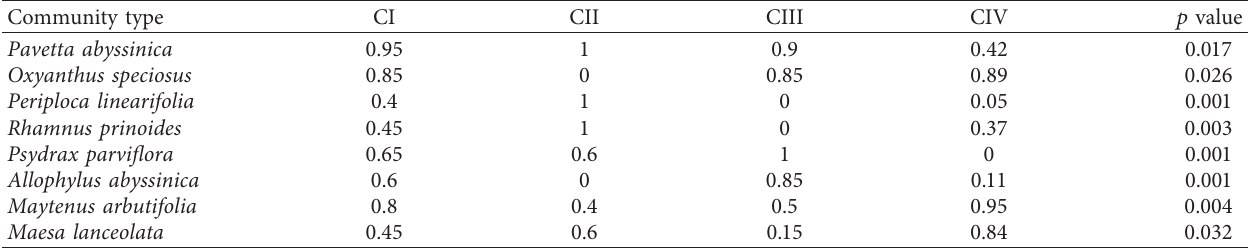
Table 2: Indicator species for each community type and the test significant ∗∗ p value